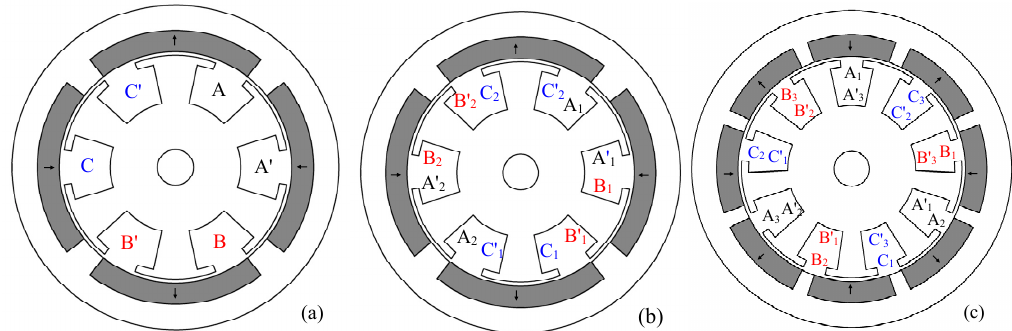
Figure 2. Winding topologies ( a ) single layer alternate teeth wound ( b ) double layer all teeth wound non-overlapping ( c ) double-layer overlapping.